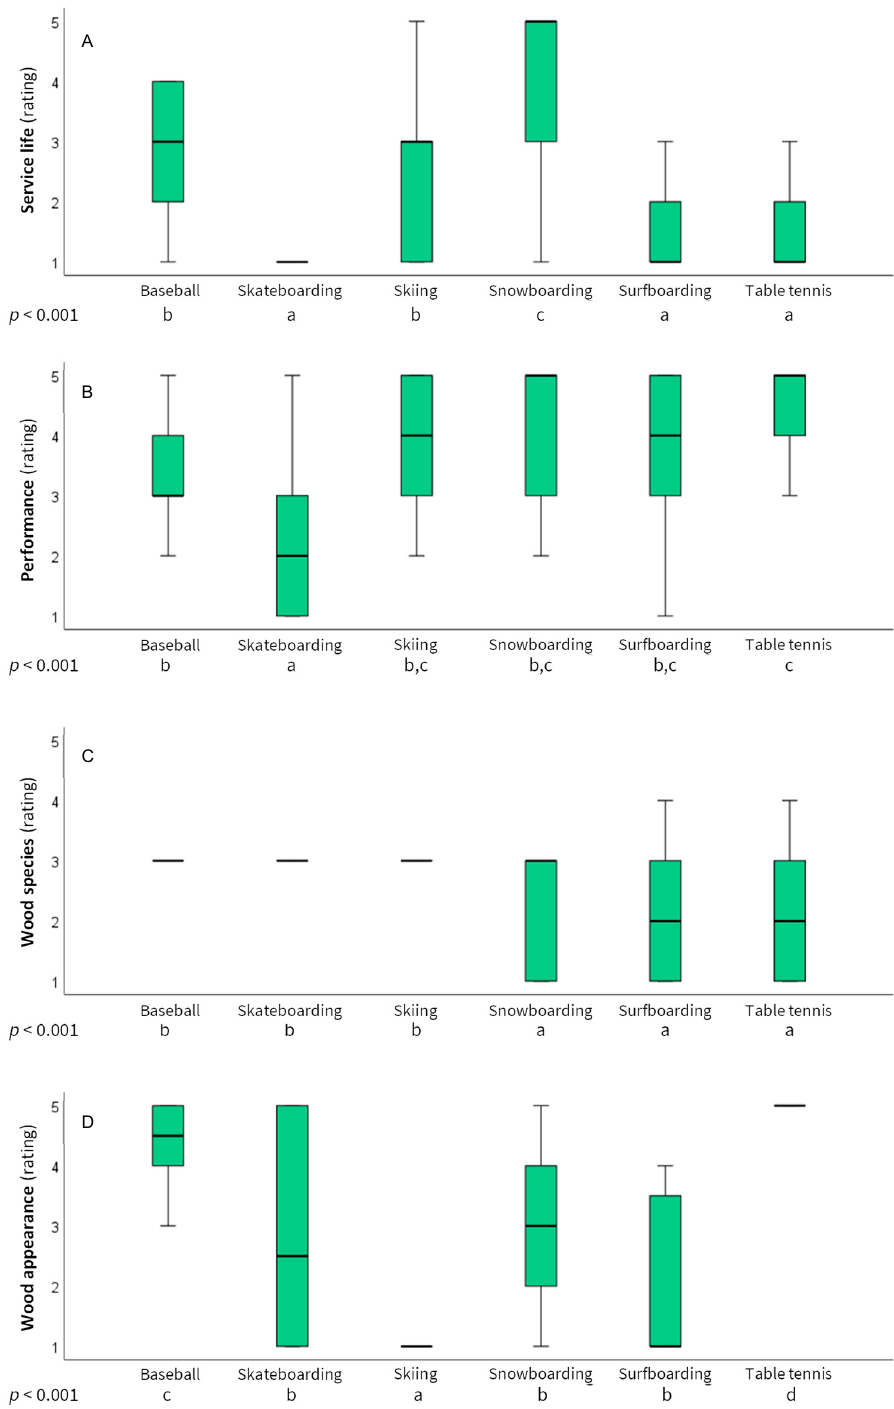
Figure 5. Results of the evaluation of the “Wood technology” dimension, and grouping (a–d) based on statistical analysis. The subfigures show the results of the various Sub-Dimensions, namely Service life (A), Performance (B), Wood species (C), and Wood appearance (D).